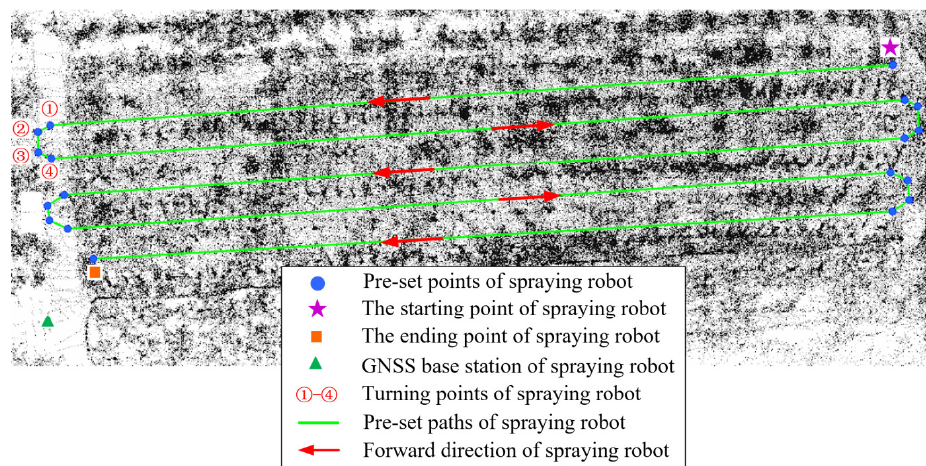
Figure 18. Pre-set paths for spraying robot.